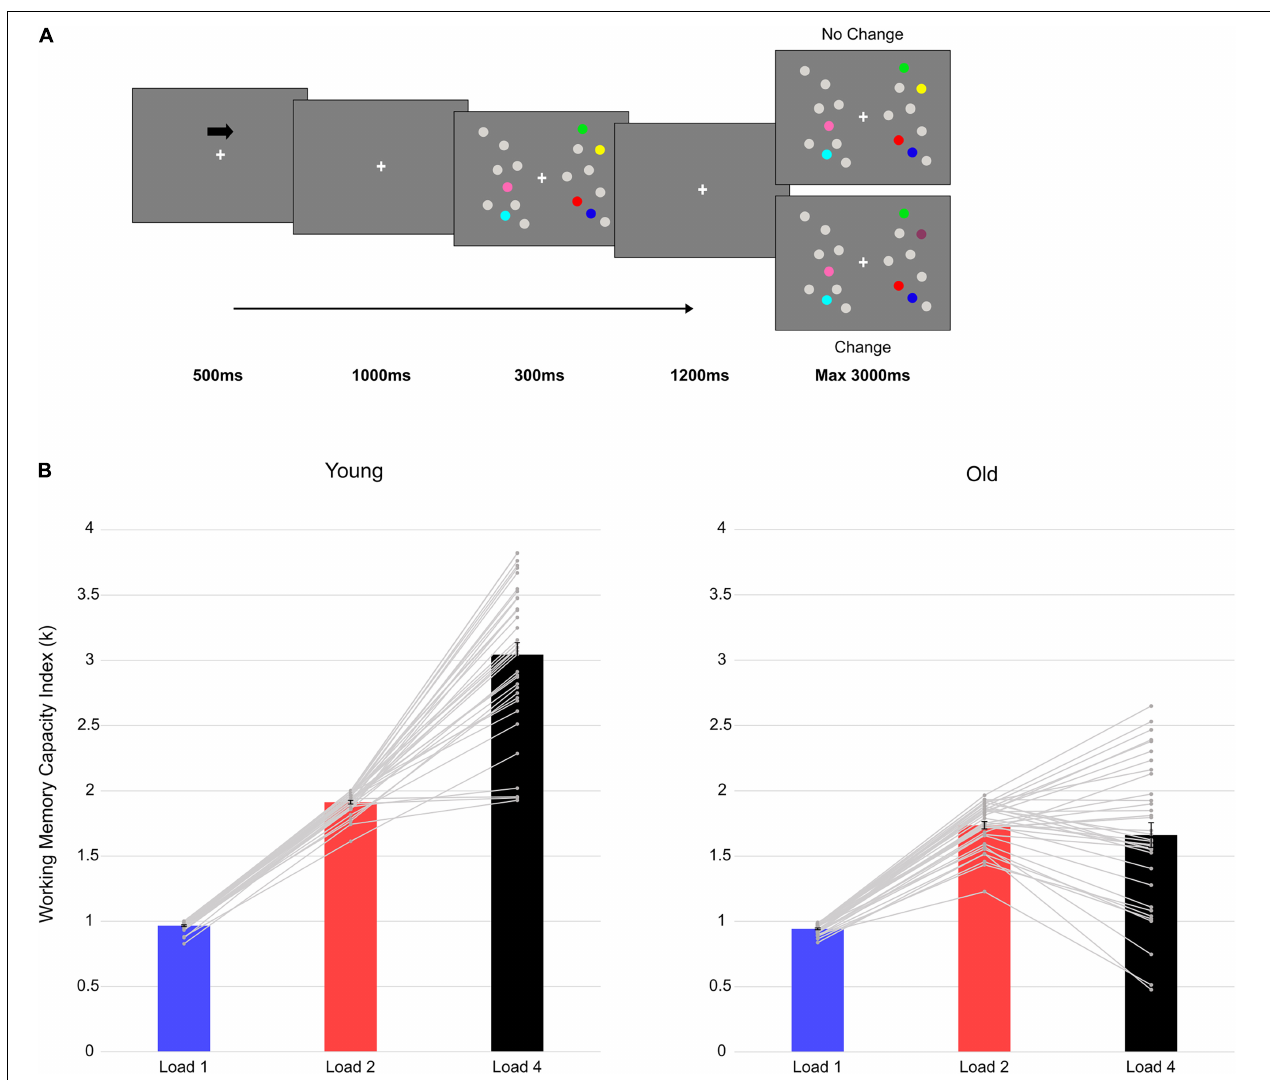
FIGURE 1 | Trial structure and behavioral results. (A) An example with four targets (Load4) presented in the right hemifield. (B) Mean vWM capacity Index (k) in the two groups at each load condition. The gray lines represent single-subject data and the vertical bars represent the standard